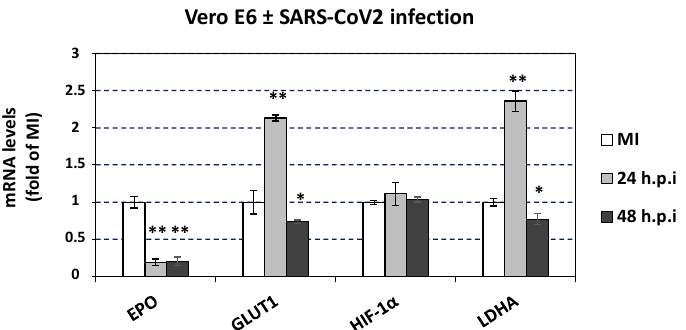
Figure 13. Effect of SARS-CoV-2 infection in DDC , EPO , GLUT1 , HIF-1 α and LDHA gene expression in infected cultured cells. Vero E6 cells were infected or mock-infected (MI) with virions of the SARS -CoV-2 isolate 30–287 of lineage B1. The cells were lysed at 24 and 48 h post-infection. The mRNA levels of DDC , EPO , GLUT1 , HIF-1α , and LDHA were quantified by RT-qPCR and the mRNA levels of the housekeeping gene YWHAZ was used for normalization. Bars represent mean values from three independent experiments in triplicates. Error bars indicate standard deviations. p -values were determined by Student’s t -test. * p < 0.001, ** p < 0.0001 vs. MI. 3.9. Meta-Analysis of the Direct Protein-Protein Interactions of the Catecholamine Biosynthe-